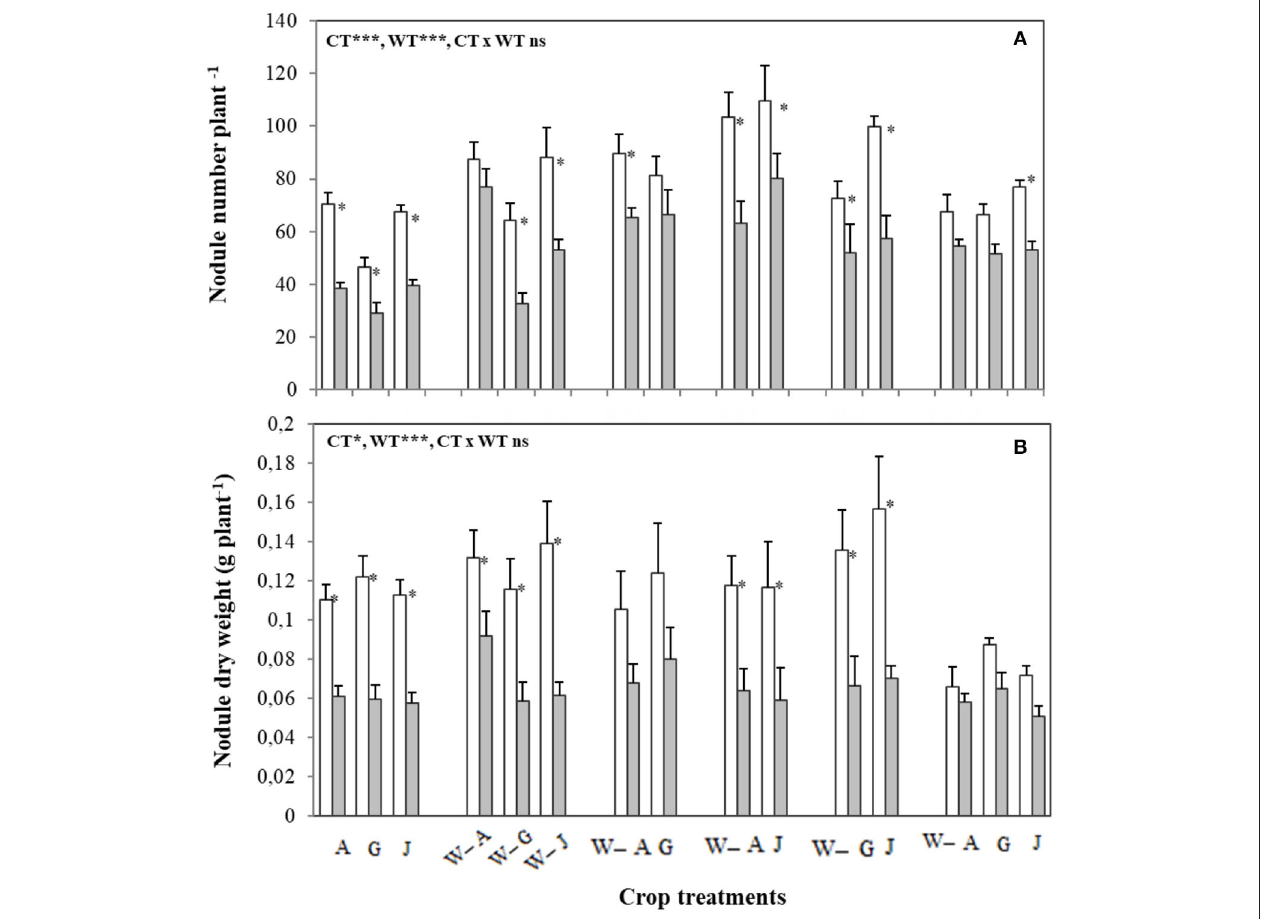
FIGURE 3 | Number (A) and dry weight (B) of nodules of the three faba bean varieties, A, G, and J, grown as sole crops (A, G, and J) or intercropped with W under adequate watering (80% field capacity; open bars) vs. water-stressed (30% field capacity, filled bars) conditions. Data are means and SE of six replicates harvested at 49 days post-transplantation. An asterisk * denotes a significant difference at p <